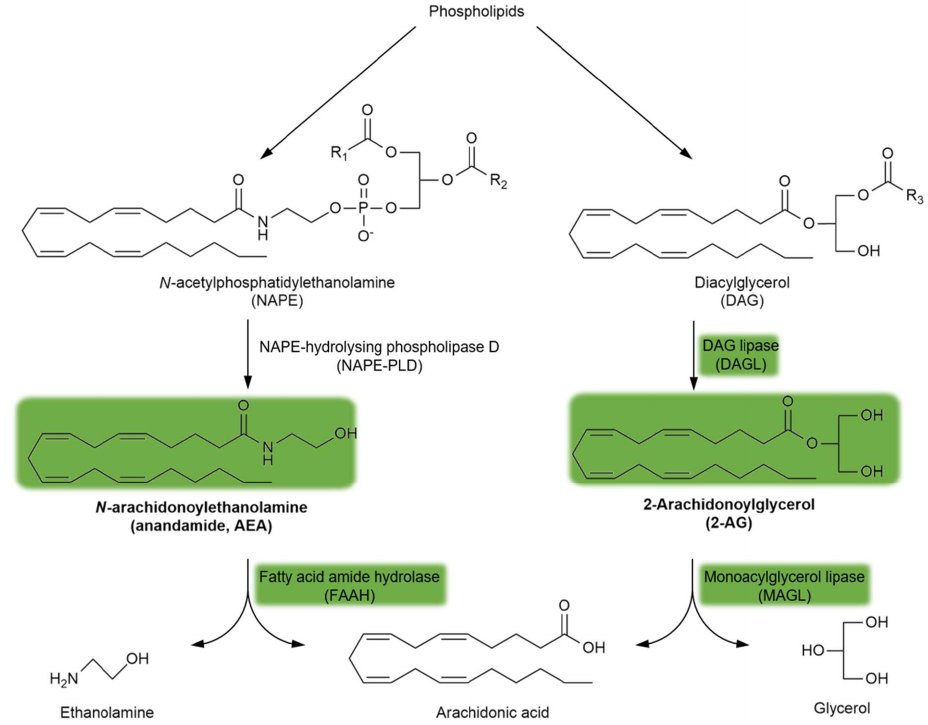
Figure 3. The synthesis and degradation of endocannabinoids. The green background indicates the metabolites and enzymes relevant to schizophrenia. Abbreviations of metabolites and enzymes frequently used in the text are also indicated.